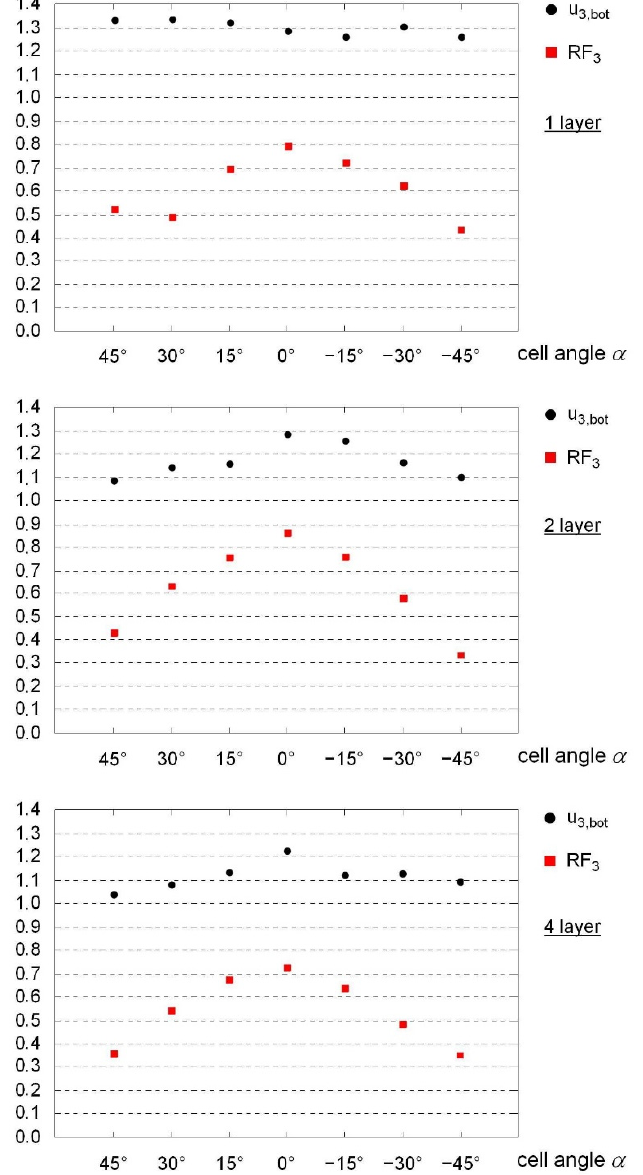
Figure 26. Three ‐ dimensional lattice cores: normalized maximum values for displacement 𝑢 (cid:2871),(cid:2912)(cid:2925)(cid:2930) Figure 26. Three-dimensional lattice cores: normalized maximum values for displacement u 3,bot and and reaction force RF 3 . reaction force RF 3